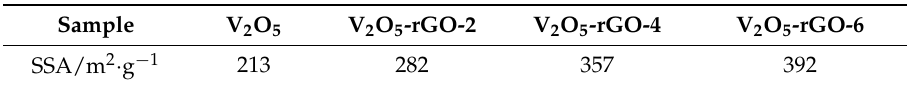
Table 2. BET-specific surface area of the V 2 O 5 aerogel and V 2 O 5 -rGO hybrid aerogels prepared by Method II.